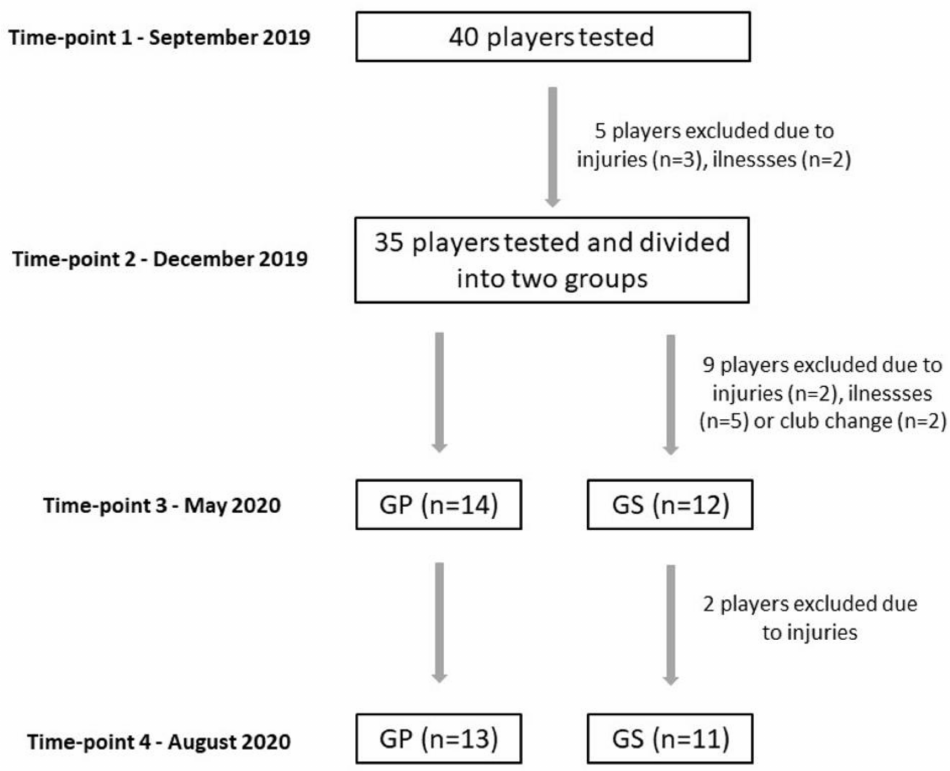
Figure 1. Timeline of the study design and flowchart of the